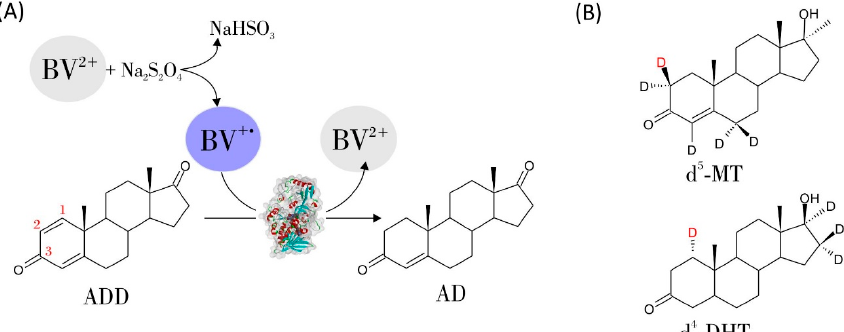
Figure 1. ( A ) The scheme of the 1,2-hydrogenation of ADD to AD catalyzed by AcmB from S. denitrificans with benzyl viologen (BV + ) as an electron donor, generated in situ by reducing BV 2+ with sodium dithionite (Na 2 S 2 O 4 ). ( B ) Deuterium-labelled substrates used in transhydrogenation experiments: 2,2,4,6,6-d 5 -17-methyl-testosterone (d 5 -MT) and 1,16,16,17-d 4 -dihydrotestosterone (d 4 - DHT). Deuterons H2 β at C2 of d 5 -MT and H1 α at C1 of d 4 -DHT are marked in red.